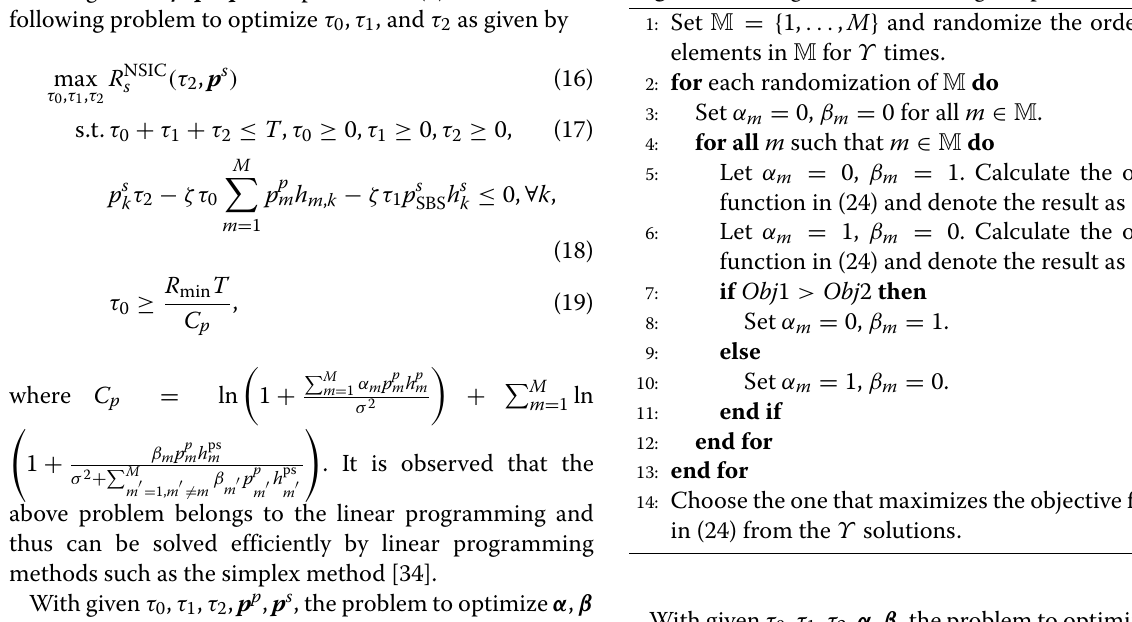
Algorithm 1 Algorithm for solving the problem in